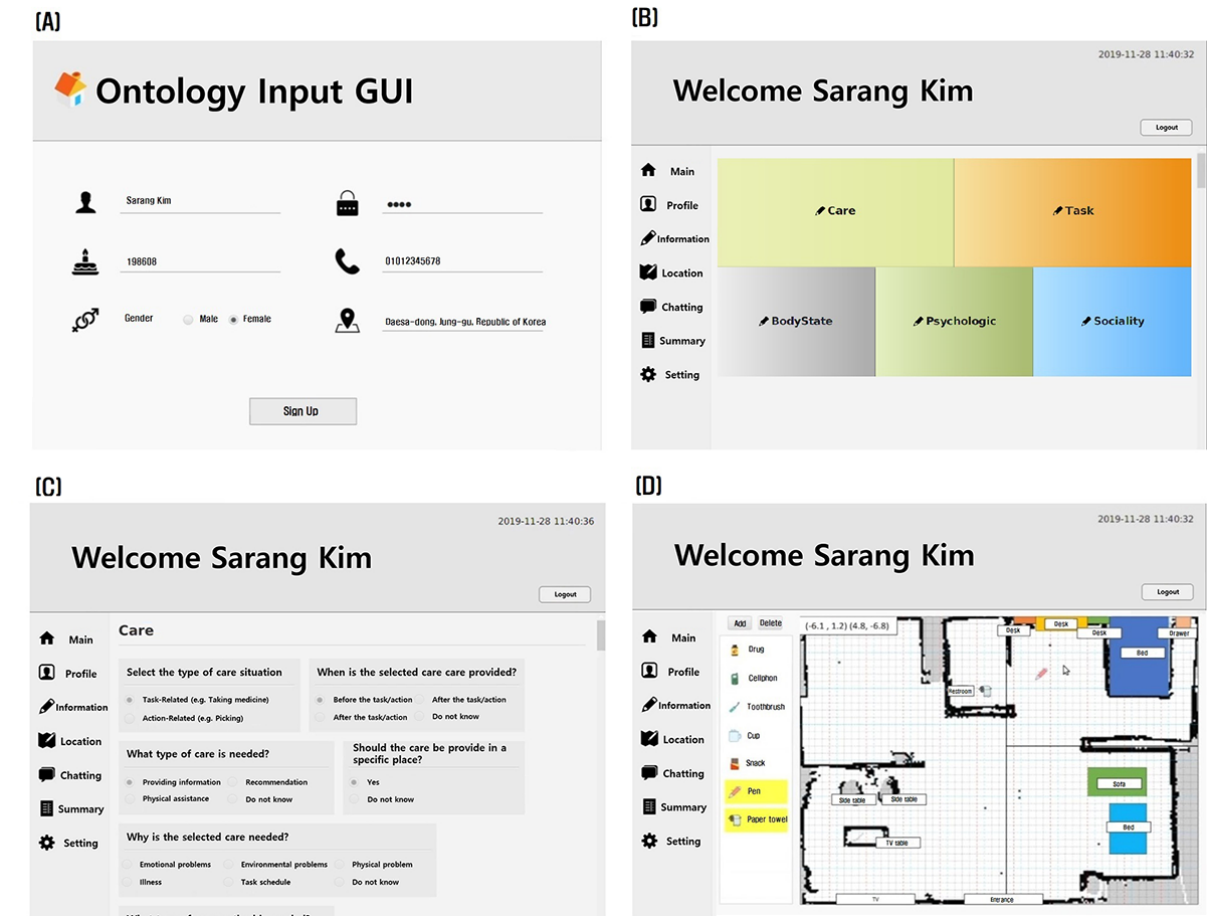
Figure 6. The graphical user interface design for care knowledge management: (A) an example of writing personal information on registration page, (B) selecting one of five different categories of assessment for persons with dementia, (C) updating assessment instances for care method, and (D) checking and updating the location of